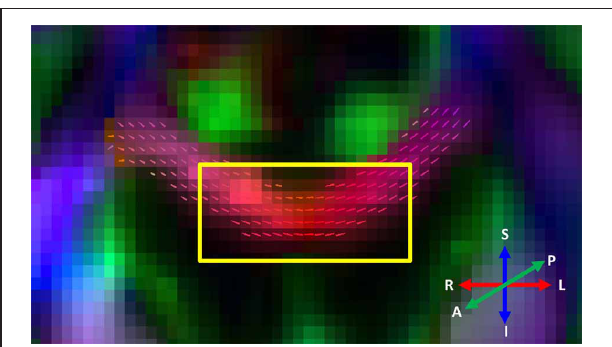
FIGURE 2 | Color-coded FA map of a coronal slice through the body of the corpus callosum. The DWS VOI dimensions (20mm RL × 8mm FH) in that plane are represented by the yellow rectangle. The ticks in each voxel represent the direction of the main diffusion eigenvector. The resulting directional range is significant, approximately ± 20 ◦